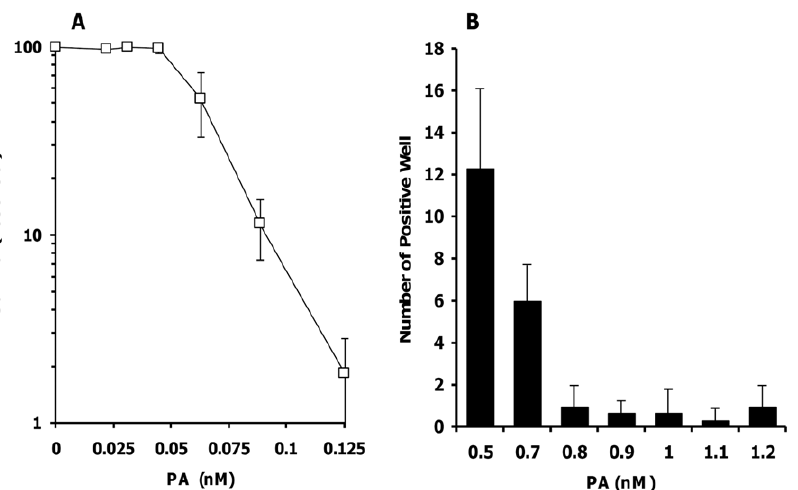
Figure 2. Cell survival after PA exposure. ( A ) In a low cell density experiment using a 24-well plate (2.5 6 10 3 cells/250 m L/well), DT40 cells were exposed to PA (0.0221–0.125 nM). After a three-day cultivation, cell viability was determined by XTT. Each point represents the mean and S.D. (bars) from three independent experiments. ( B ) In a high cell density experiment using a 96-well plate (4 6 10 4 cells/50 m l/well), DT40 cells were exposed to PA (0.5–1.2 nM). After a seven-day incubation, colony formation was scored visually using an inverted microscope. Each point represents the mean and S.D. (bars) from three independent experiments.